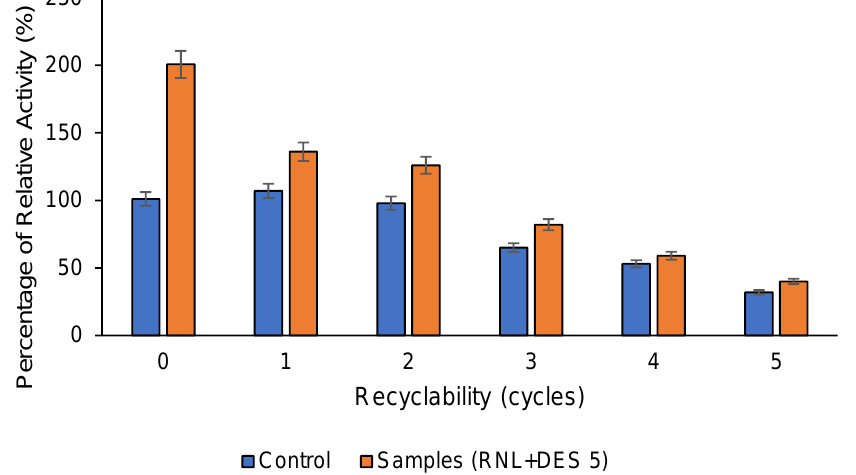
Figure 7. Recyclability of RNL (control) and RNL@DES-5 (sample). DES5 = menthol:decanoic acid (1:1) and RNL = Rhizopus niveus lipase. Conditions: concentration of lipase: 1 mg mL − 1 , 2 h, 300 rpm, 40 °C, and pH 7.0.